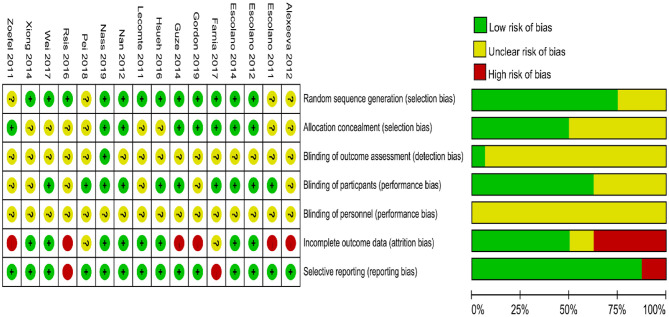
Cochran risk of bias tool. Each risk of bias item for each included study and presented as percentages across all included studies.